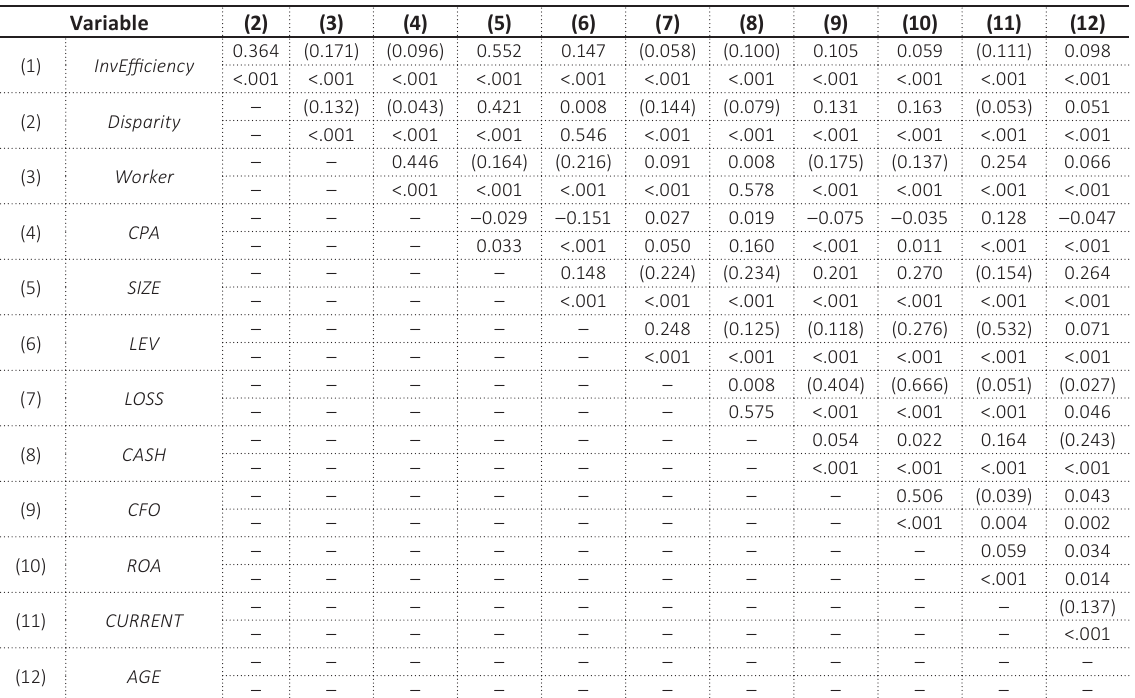
Table 2. Correlations (p-values below)